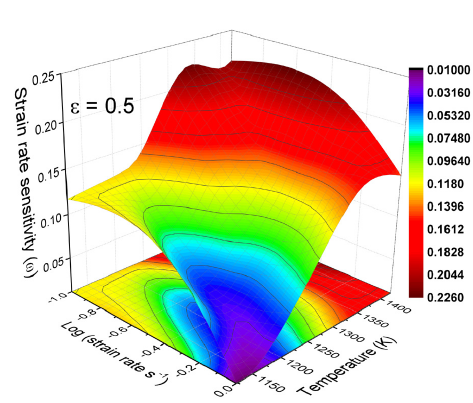
Figure 4. Surface plot of the effect of strain rate and temperature on the strain rate sensitivity at 0.5 of plastic